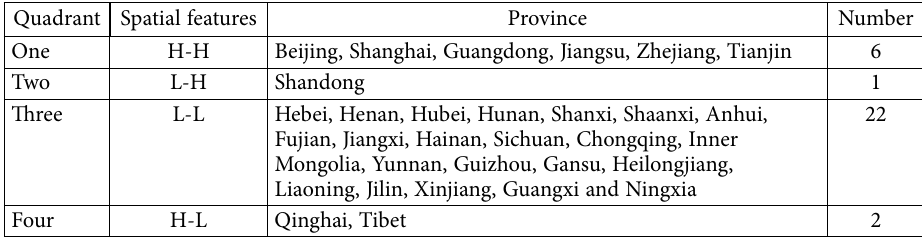
Table 6. Characteristics of DDE space in 2019 Quadrant Spatial features